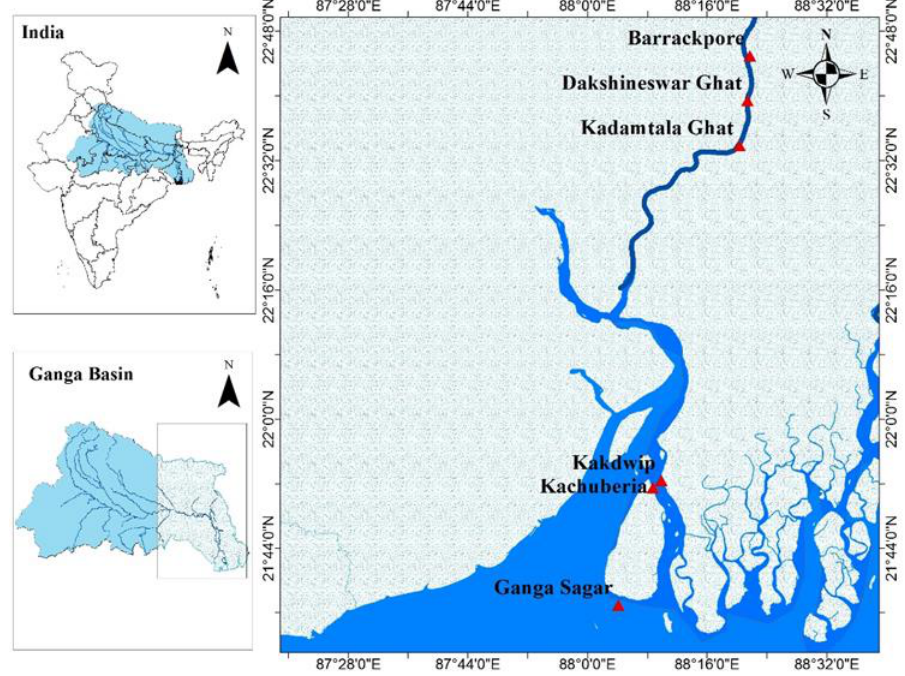
Figure 1. Geographic distribution of sampling sites along the Hooghly River estuary. Red triangles indicate the location of six sampling stations from Barrackpore to the confluence at Gangasagar (Bay of Bengal).